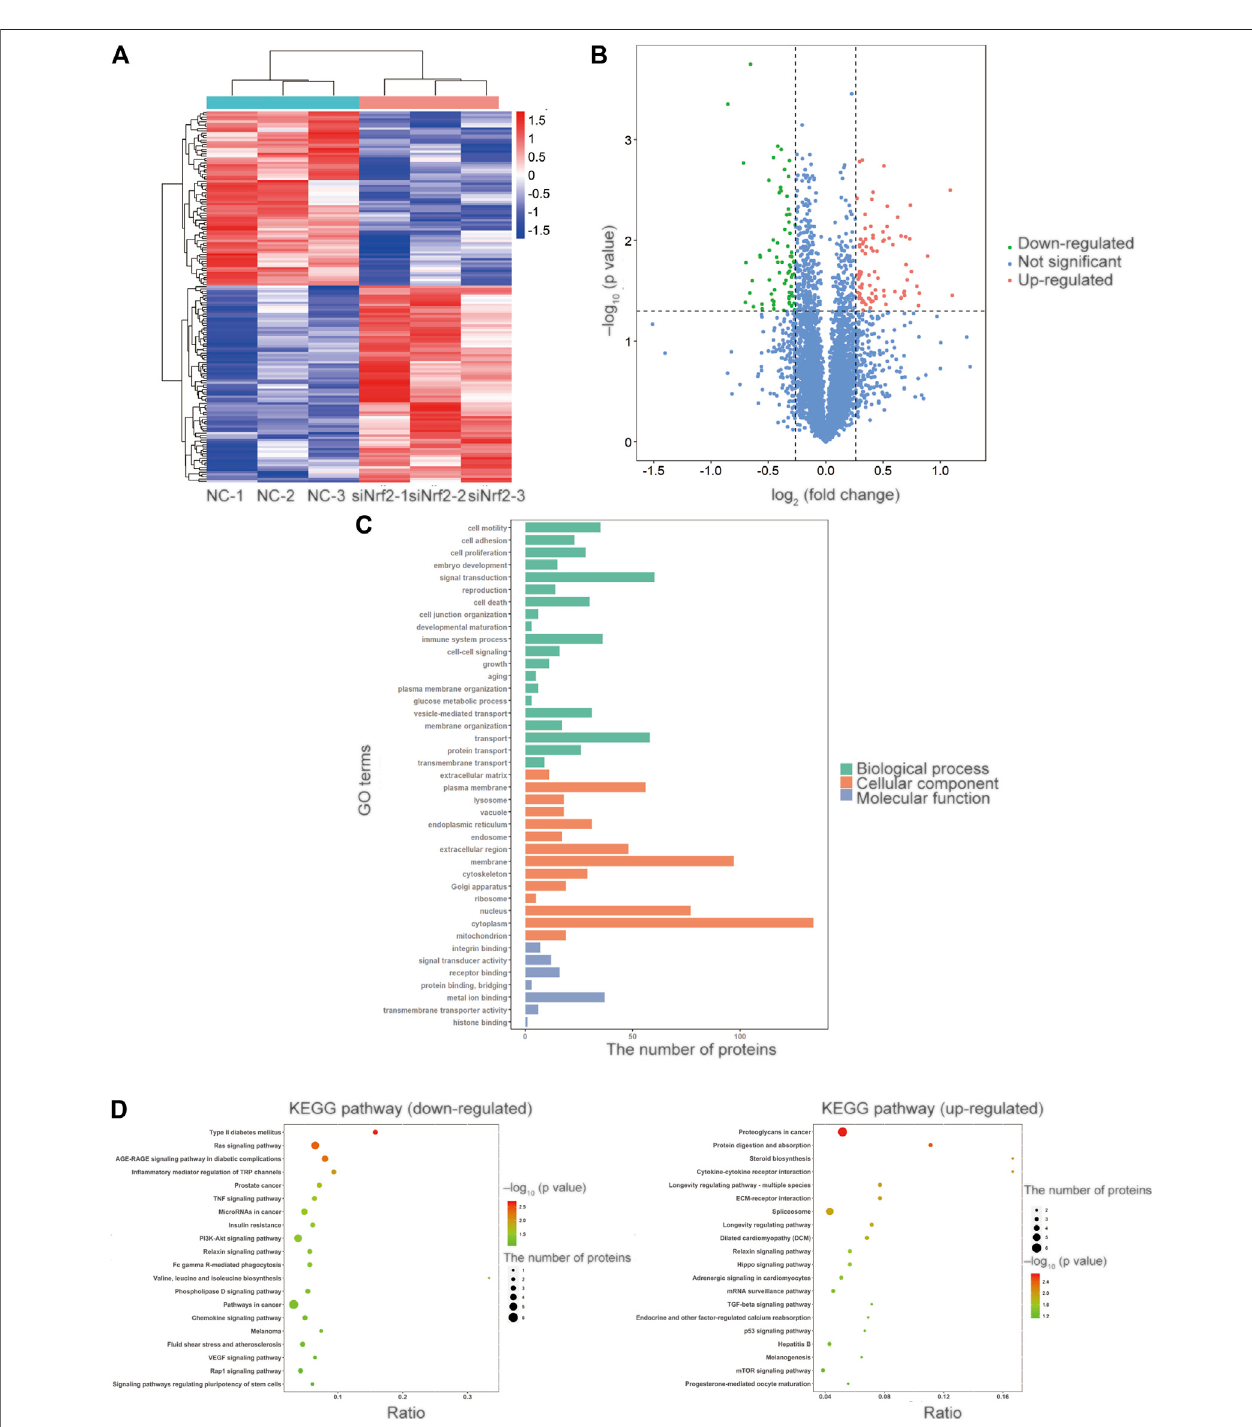
FIGURE2| Identi fi cationofthedifferentiallyexpressedproteinsandbioinformaticsviaTMT-basedLC-MS/MSanalysis. (A) Theheatmapoftherelativeabundance ofproteins ineachsample. (B) Thevolcanoplotshowed162proteins weredifferentially expressed compared withthecontrolproteins, including 76downregulated and 86upregulated proteins. Theproteinswiththe p valuelessthan0.05andthefoldchangemorethan1.2orlessthan0.833wereselectedandrecognized asdifferentially expressedproteinsforfurtherstudy.Thevalueoflog 2 (foldchange)wassetasabscissa,andthevalueof-log 10 ( p value)wassetastheordinate. (C) GOenrichment analysisrevealed thatthe differentially expressed proteins were involvedin thecellular component(CC) category,thebiologicalprocess (BP)categoryand the molecular function (MF) category. (D) The KEGG pathway enrichment analysis of the up-regulated and down-regulated proteins.